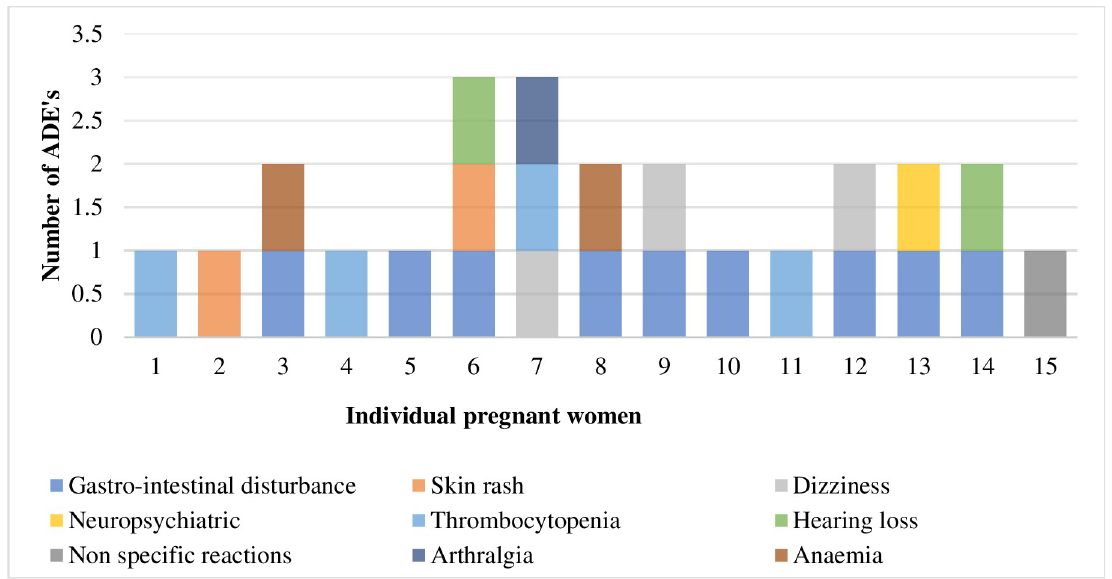
Fig 2. Pregnant women and the reported adverse drug events (n =